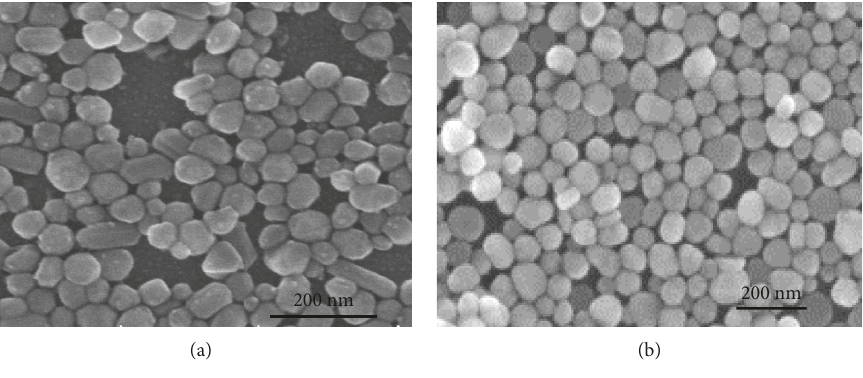
Figure 2: SEM characterization of two silver sols.